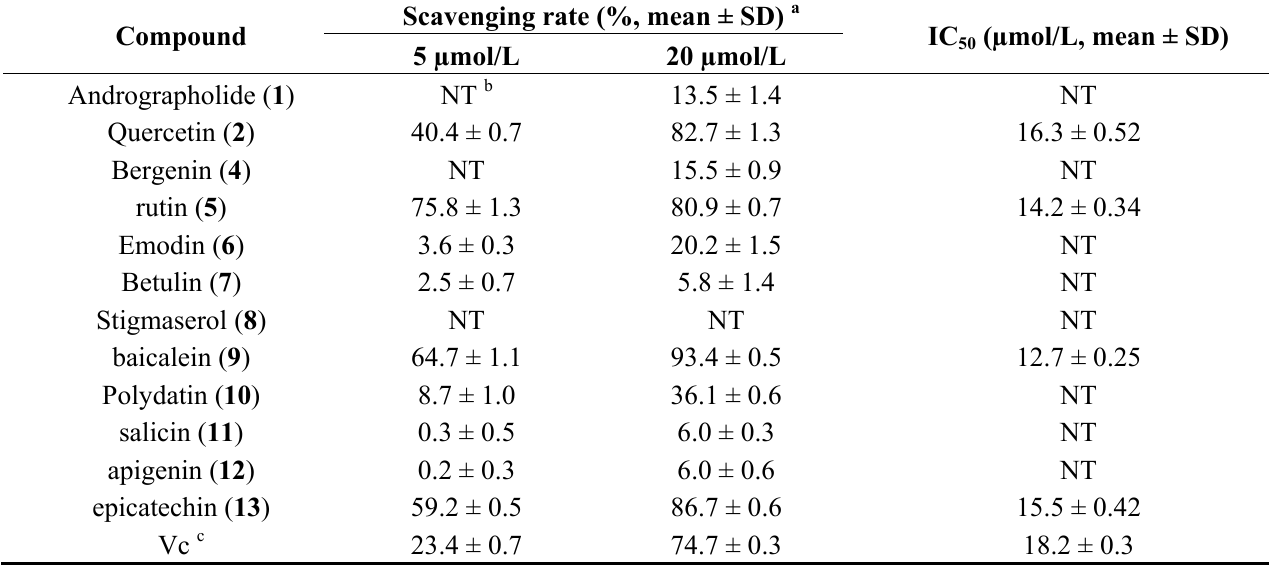
Table 2. Antioxidant activities of the tested compounds from Caesalpinia decapetala (Roth) Alston on DPPH scavenging